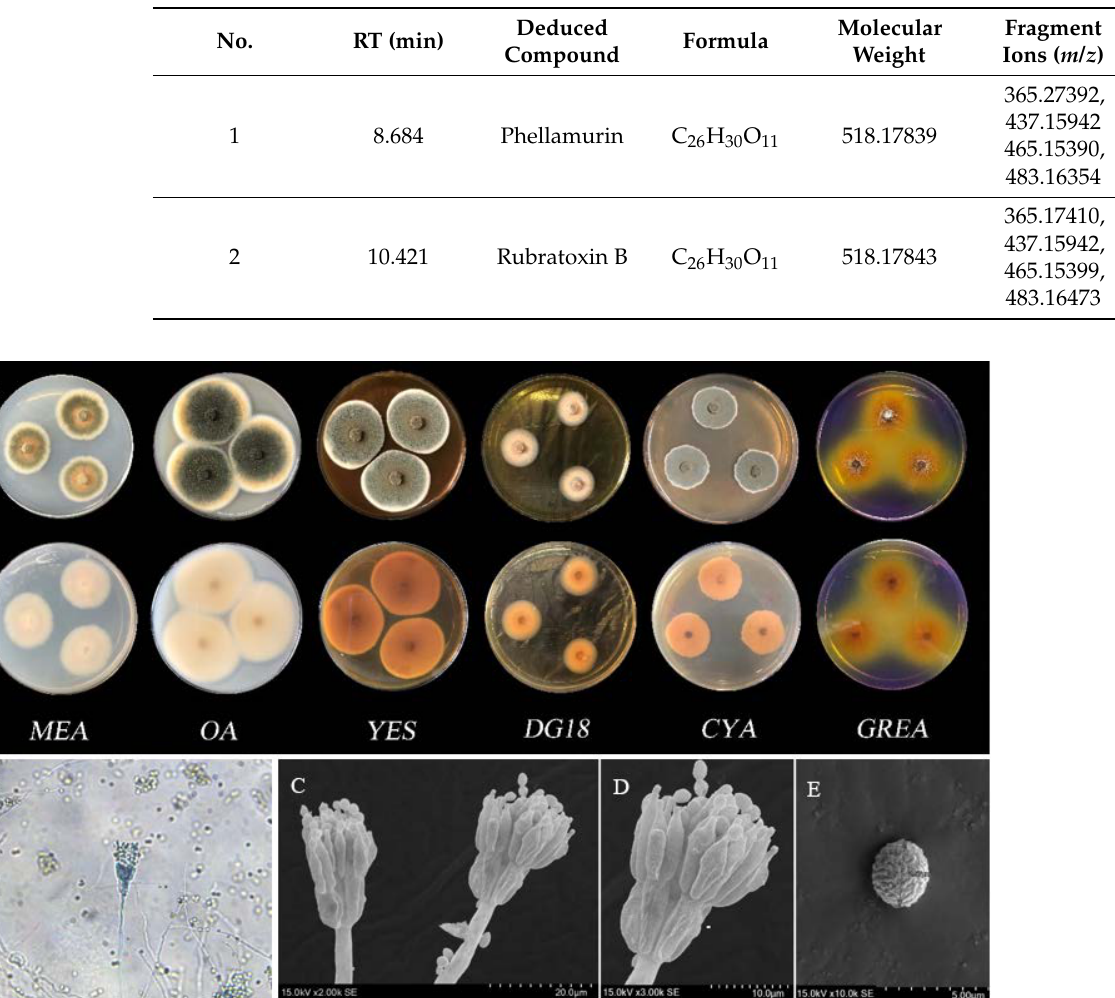
Table 4. Chromatography and mass spectrometry information in the components of Fr.2.2.2.